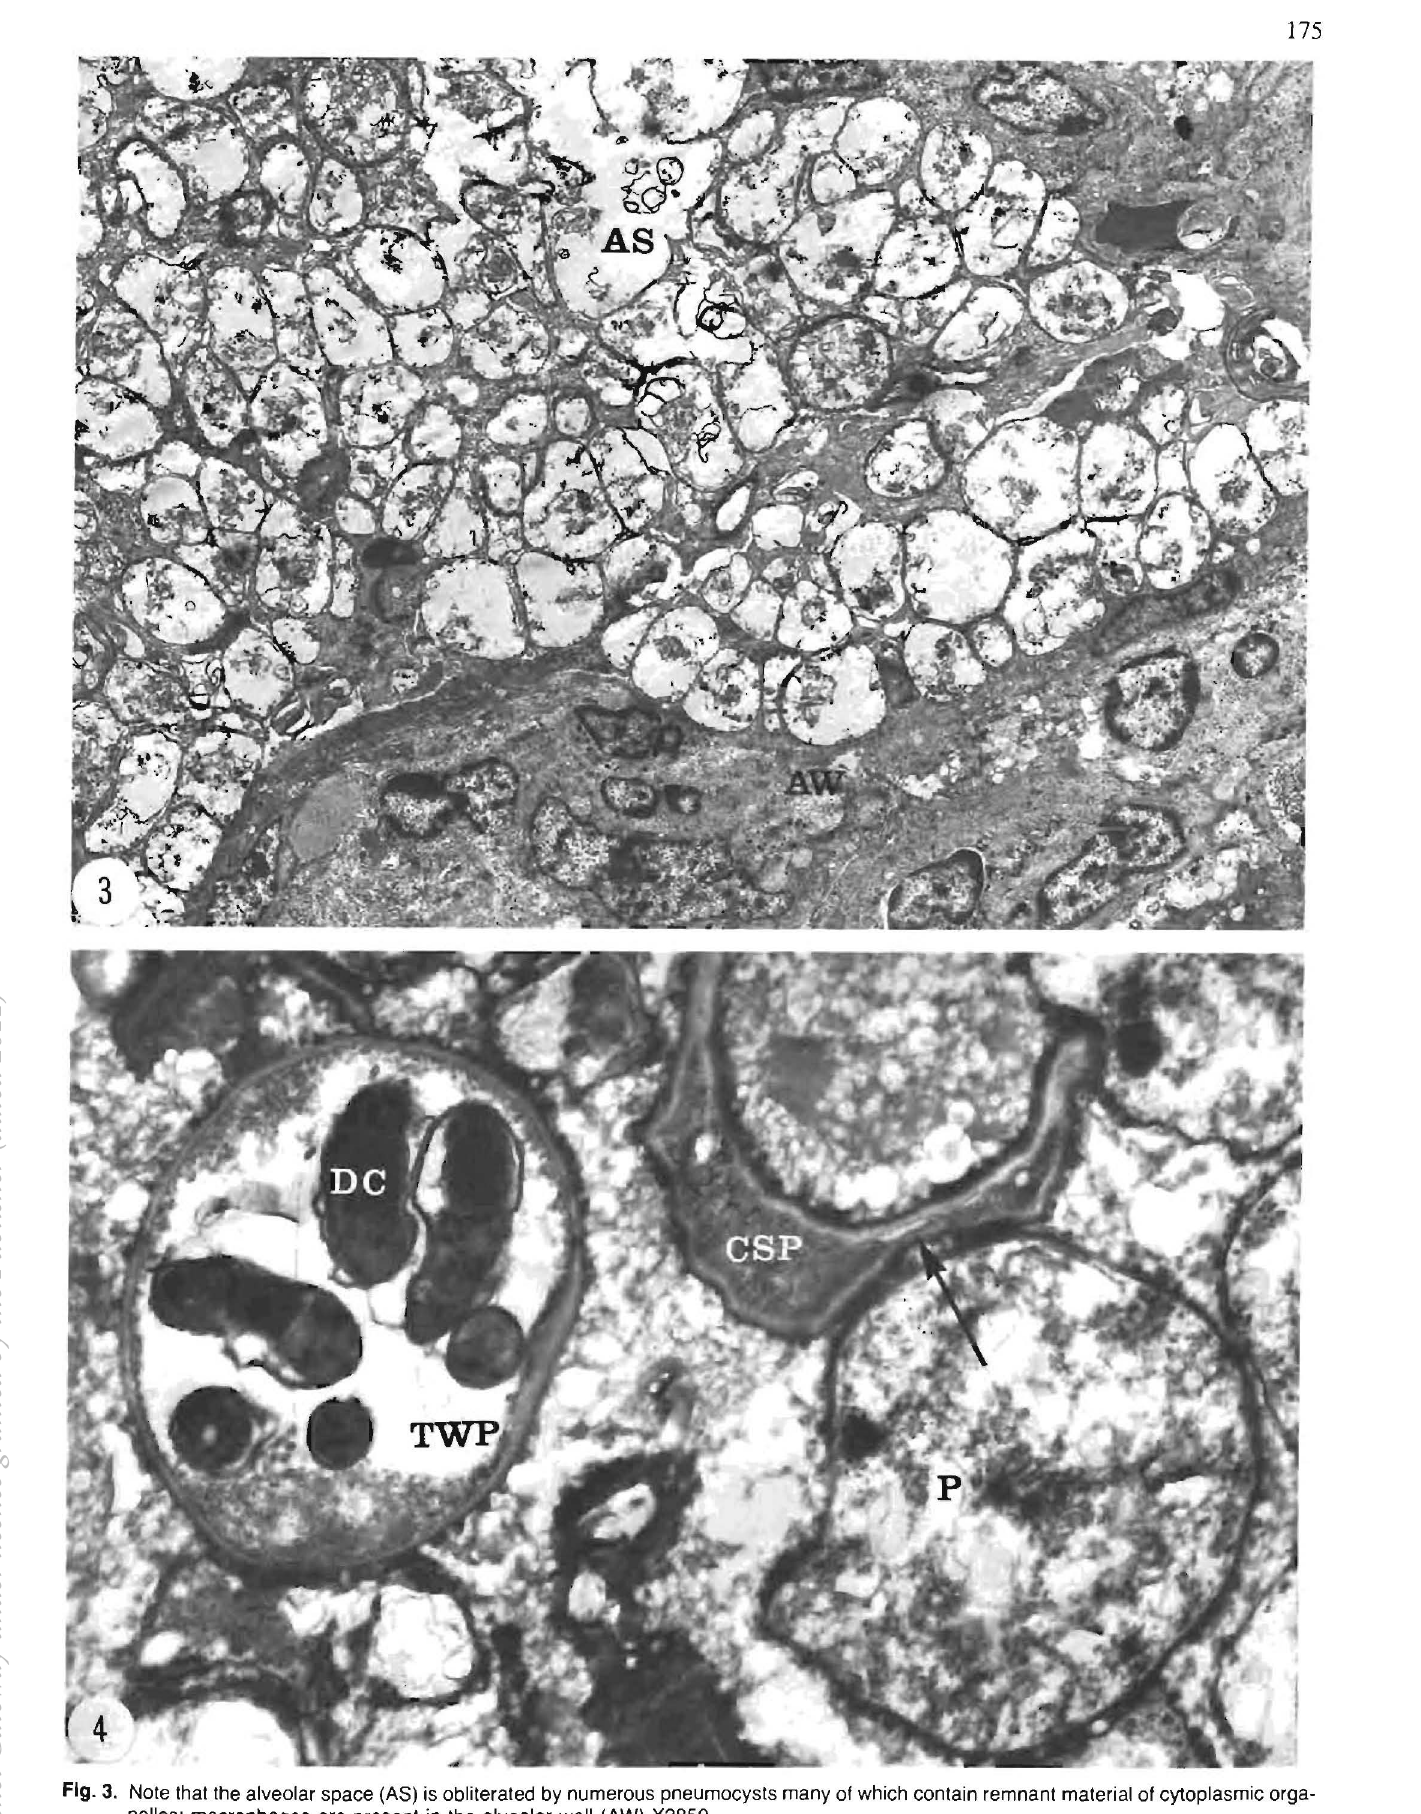
Fig. 3. Note that the alveolar space (AS) is obliterated by numerous pneumocysts many of which contain remnant material of cytoplasmic orga nelles; macrophages are present in the alveolar wall (AW) X3850 Fig. 4 A thick-walled pneumocyst (TWP) contains six highly electron dense daughter cells (DC) some of which are kidney shaped. A crescent shaped pneumocyst (CSP) is Indented by a thin-wailed pneumocyst (p) (Indicated by the arrow), X18750